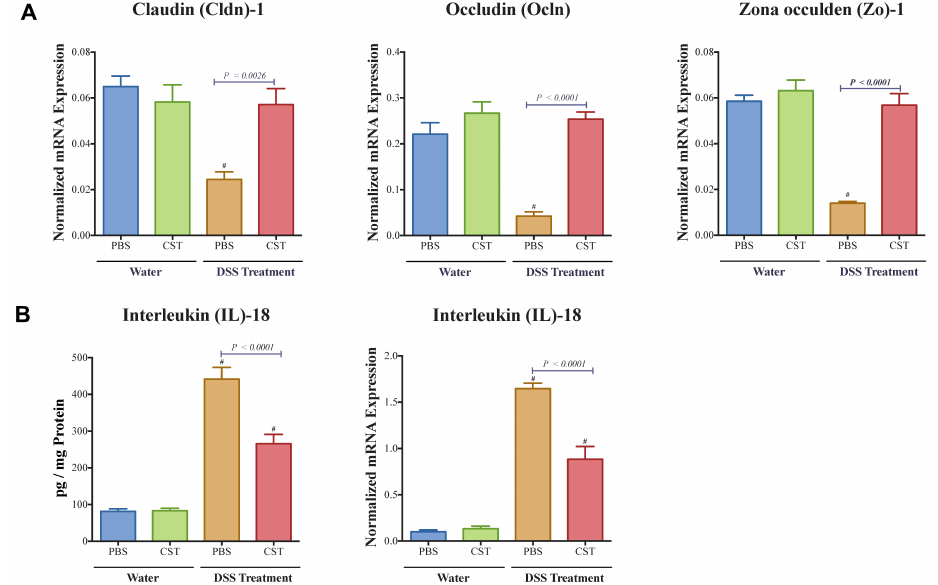
Figure 5. Catestatin (CST) maintains colonic mRNA levels of tight junction (TJ) proteins and reduces interleukin (IL)-18 release in dextran sulfate sodium (DSS)-induced colitis. Treatment with CST (1.5 mg/kg/day) or 1 × phosphate buffer saline (PBS) started one day prior to DSS colitis induction. ( A ) Colonic mRNA levels expression of TJ proteins (Claudin ( Cldn1 ), zonula occludens-1 ( Zo1 ), and occludin ( Ocln ); ( B ) Colonic protein and mRNA levels expression of Il-18 . One-way ANOVA followed by multiple comparison tests. Each value represents the mean ± SEM, n = 7–10 mice/group. # Compared to control water